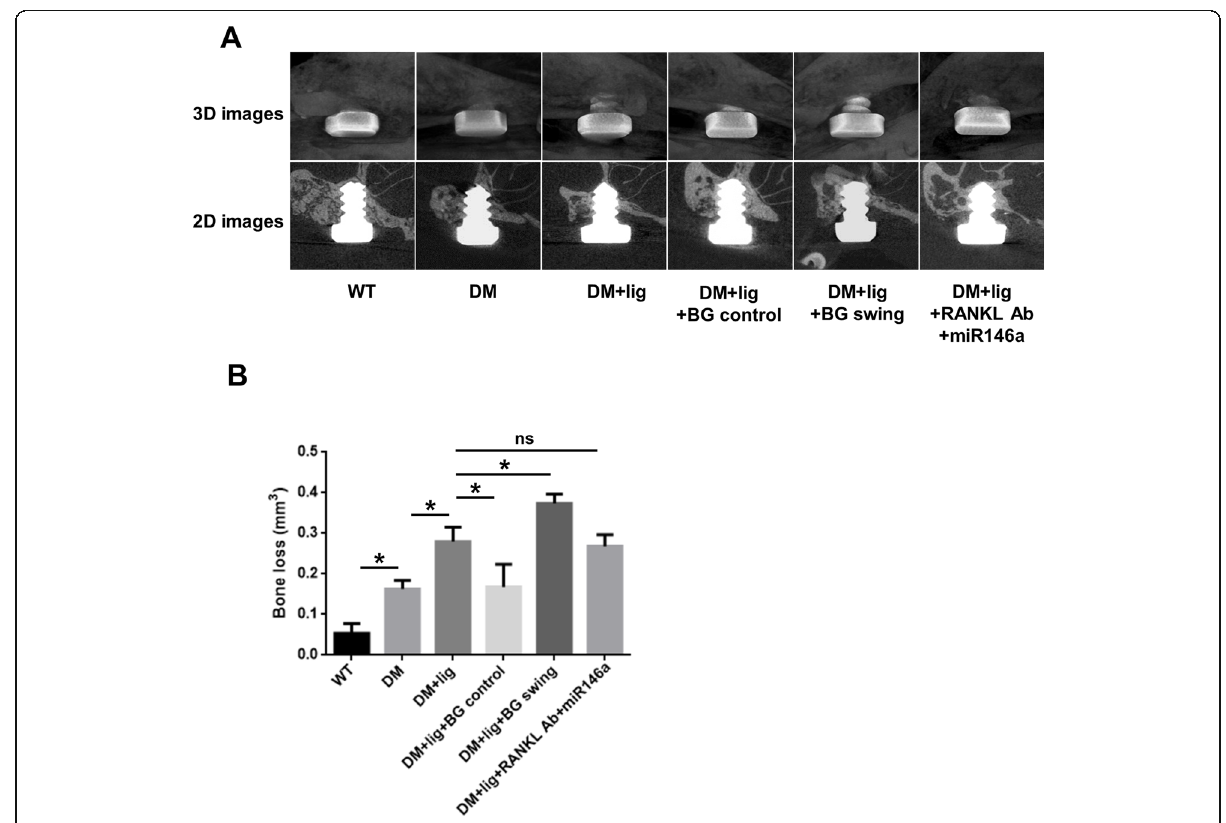
Fig. 1 Peri-implant bone loss detected using micro-CT. a Micro-CT images of mesial-distal bone surrounding implants in different groups of mice. b The peri-implant bone loss was calculated in 3D morphometric analysis (mean ± SD, n = 6, * p < 0.05; ns, no